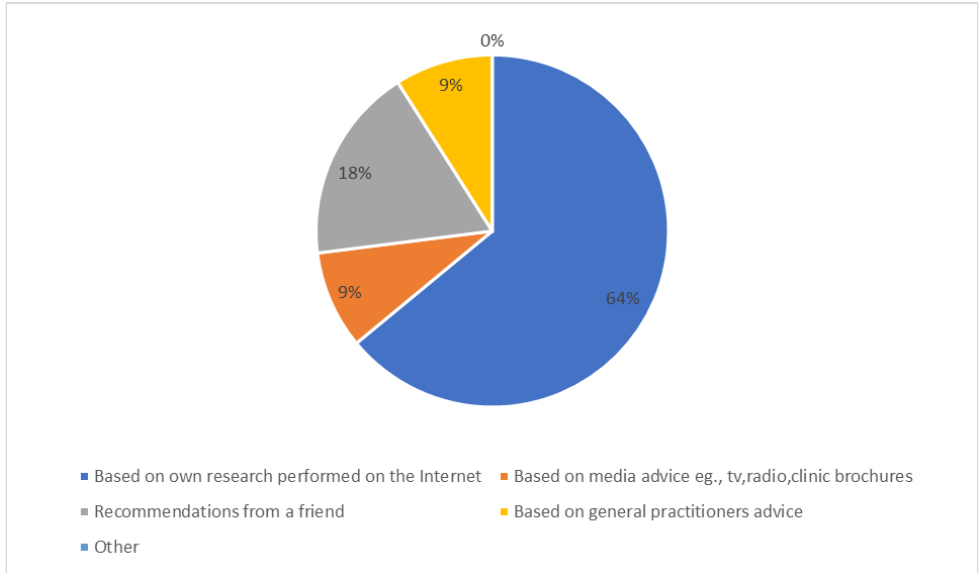
Figure 3. Reasons why the respondents in this study chose particular clinics .